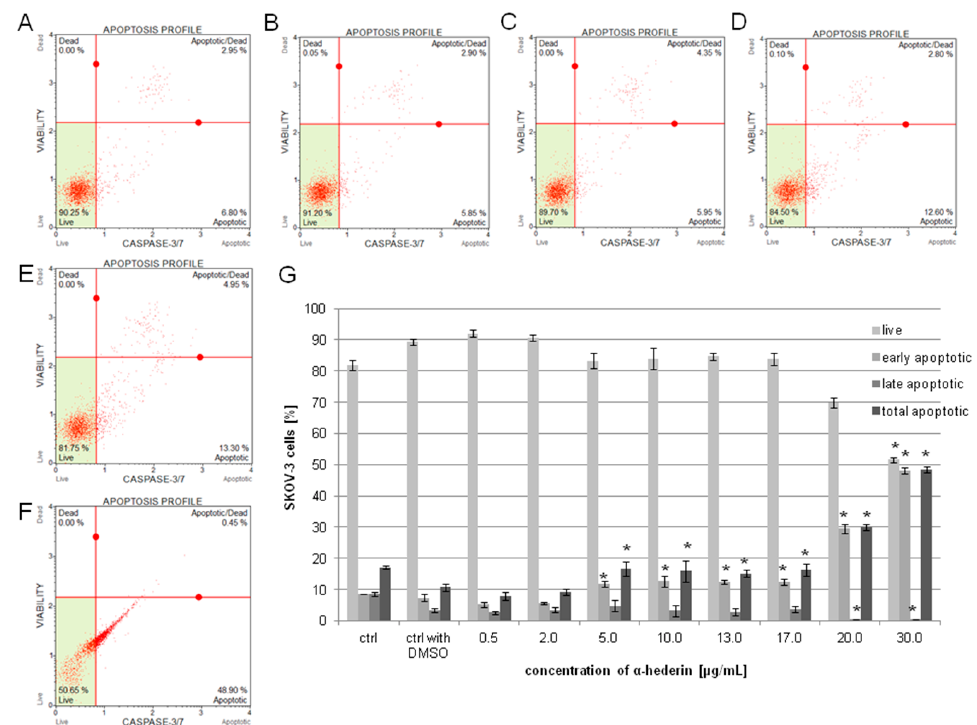
Figure 9. Caspase-3/7 activation in SKOV-3 cells treated with α -HN. Diagrams depict the mean values of early, late, and totally apoptotic cells of three independent experiments after incubation of the SKOV-3 cells with 0.3% DMSO (control with DMSO) ( A ) and increasing concentrations of α -HN in the range 0.5–30 μ g/mL for 24 h (particular concentrations are represented in pictures: 0.5 ( B ), 2 ( C ), 10 ( D ), 17 ( E ), and 30 μ g/mL ( F )). Significant differences relative to DMSO control are marked with * ( p < 0.05) ( G ). Error bars represent standard deviation. Control: the untreated cells.